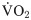
Wheel-running, mean Tb and mean Oxygen consumption of tuco-tucos in relation to diurnality indexes.Measurements for each individual (N = 9), across the stages of the experiment including days outside (white squares) and inside (black square) the respirometry chamber both with and without (grey squares) running-wheels. (A) Mean daily wheel-running levels are associated with nocturnality. (B) Mean body temperatures during each stage. There is no clear correlation with D-Indices. (C) Mean V˙O2 during each stage. There is no clear correlation with D-Indices. (D) Mean amount of general activity per day during each stage. There is no clear correlation with D-Indices.